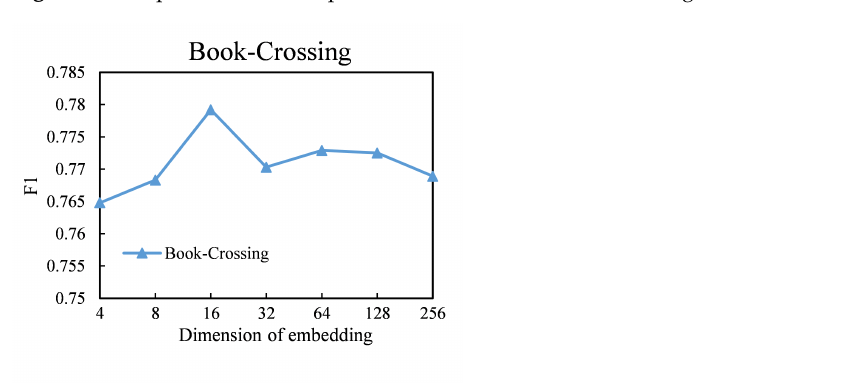
Figure 6. Comparison of the F1 performance on different embedding dimensions in Book-Crossing.